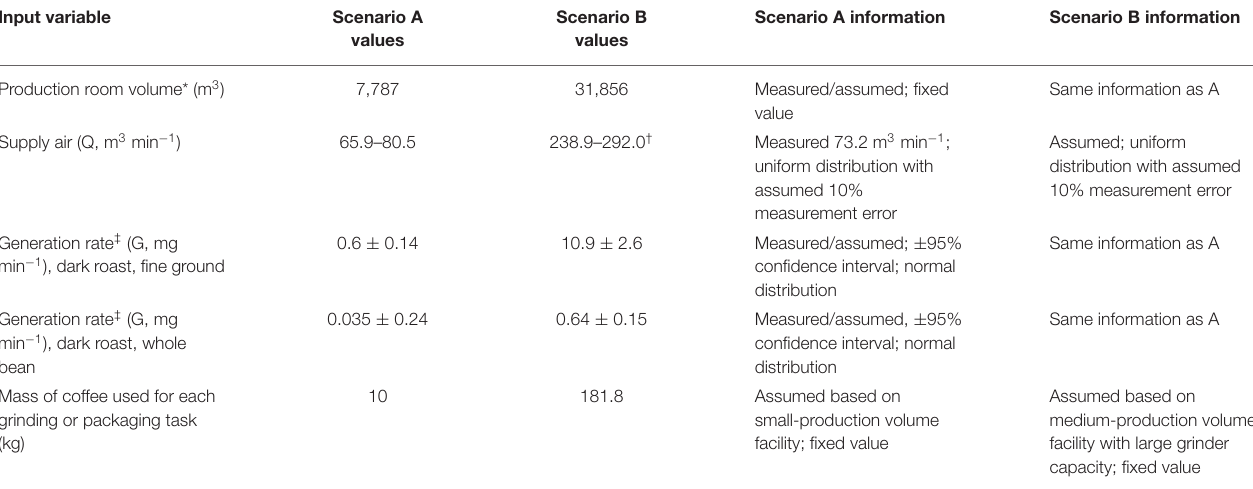
TABLE 2 | Input variables and values for model scenarios.